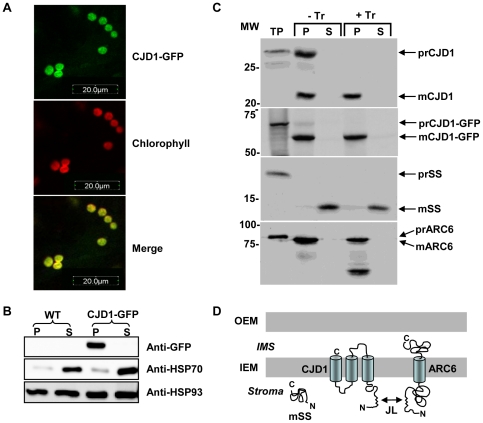
CJD1 protein resides in chloroplast membranes.A, Confocal images of Arabidopsis leaves expressing CJD1-GFP indicate that the fusion protein is targeted to chloroplasts. B, Immunoblotting of fractionated chloroplasts (membrane, P; soluble, S) probed with anti-GFP, anti-HSP70 and anti-HSP93. WT, untransformed wild-type plants; CJD1-GFP, transgenic lines expressing CJD1-GFP. C, Chloroplast import experiments with radiolabeled recombinant CJD1, CJD1-GFP, ARC6 and rubisco small subunit (SS). Chloroplasts were isolated following treatment with (+Tr) or without Trypsin (−Tr) and fractionated into membrane (p) and soluble fractions (s). TP, translation product; MW, molecular weight; m, mature protein; pr, precursor protein. D, Predicted CJD1 topology based on import assay results, published proteomics studies [28]–[30] and the location of putative transmembrane domains. OEM, chloroplast outer membrane; IEM, chloroplast inner membrane; IMS, chloroplast intermembrane space; Stroma, chloroplast stroma; JL, J-like domain.